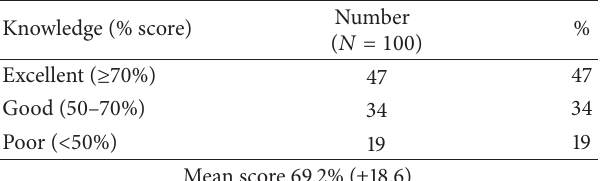
Table 1: Knowledge level of nurses about healthcare waste manage- ment according to their percentage score.